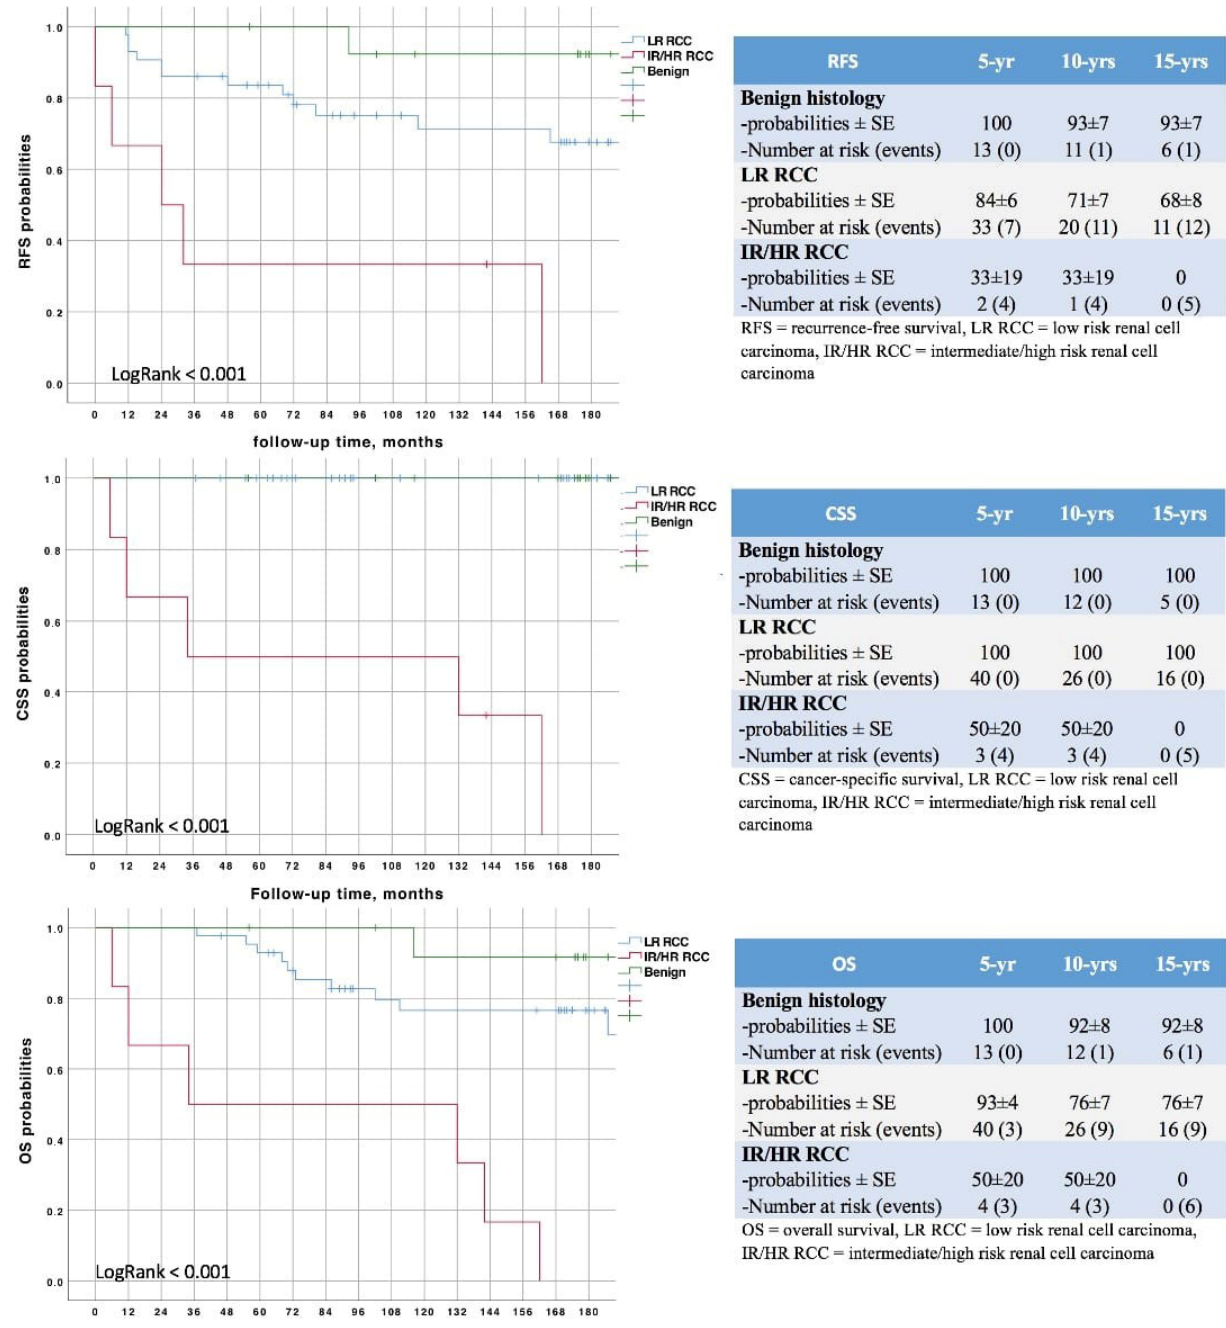
Figure 3. Survivals according to histology and Mayo Clinic and University of Southern California risk stratification systems. Overall, 52% of patients ( n = 33) achieved 15-yr ROMeS: these were younger (57 years vs. 71 years; p = 0.001), commonly female (52% vs. 23%; p = 0.021) and often harbored a benign tumor (33% vs. 10%; p = 0.026) (Tables 1 and 2). At multivariable Cox analysis, age (HR: 1.046; p = 0.033) and malignant histology (LR RCC vs. Benign HR: 3.233, p = 0.048) (IR/HR RCC vs. Benign HR: 5.721, p = 0.023) were independent predictors of ROMeS nonachievement (Table